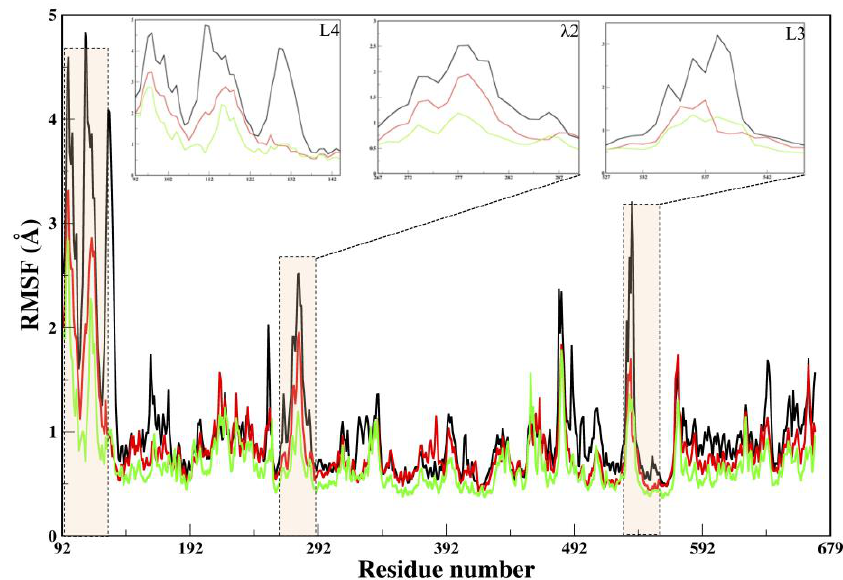
Figure 2. Dynamical characteristics of the C α atomic fluctuation, represented by RMSF of different systems elucidated through conventional MD simulations. The regions L4, λ 2, and L3, showing significant fluctuations, are highlighted in transparent bars. The insets of these regions are shown, to highlight the differences in fluctuation. The color coding of systems is as follows: black (APO), green (COM1), and red (COM2).